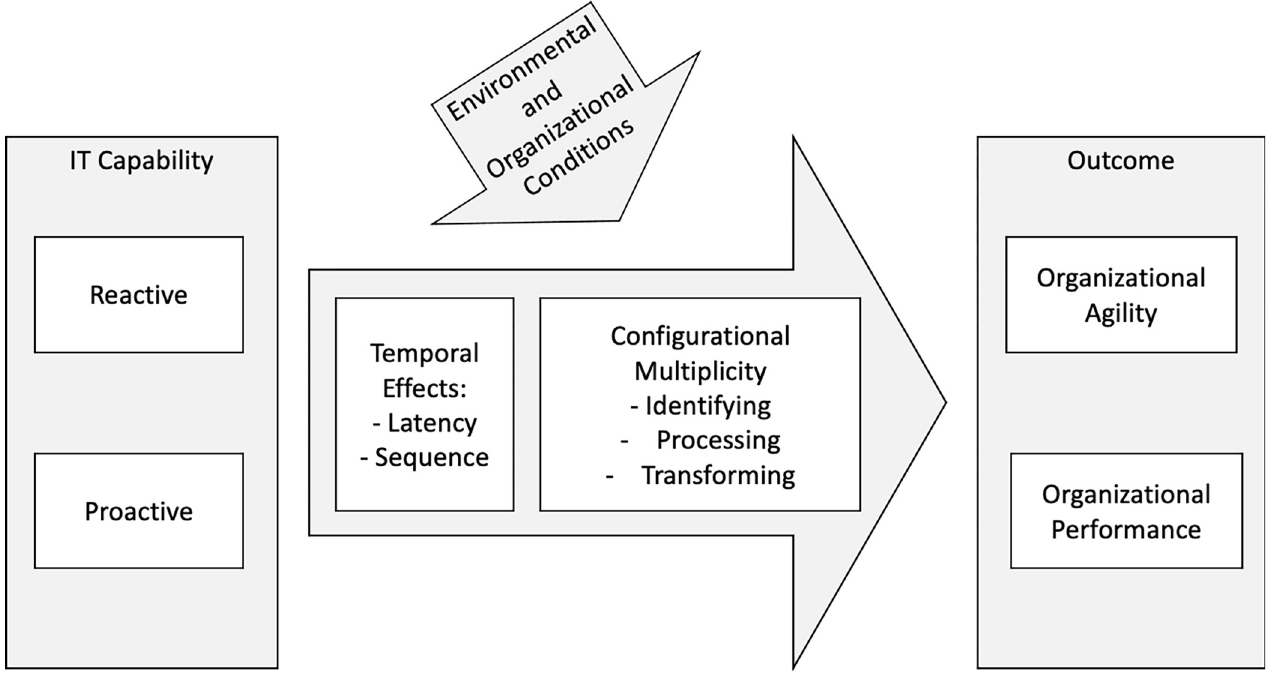
Fig 2. The nomological network of relationships between IT capability and organizational agility and performance.